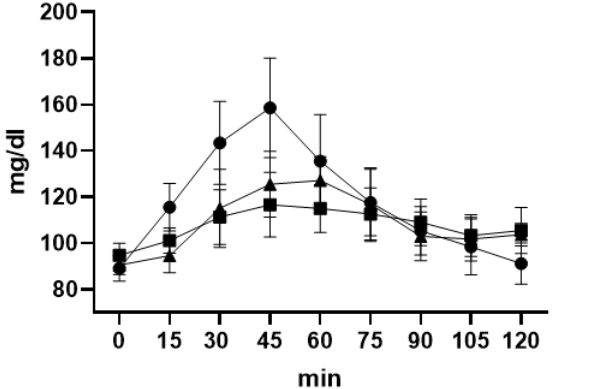
Figure 2. Taralli glycaemic curve.